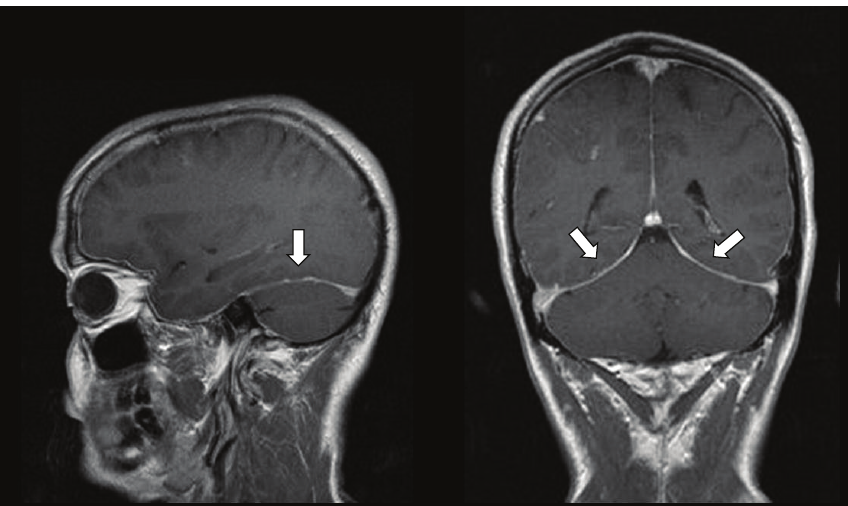
Figure 4: Brain MRI. Diffuse pachymeningeal enhancement after gadolinium administration (arrows), suggestive of liquoral hypotension.